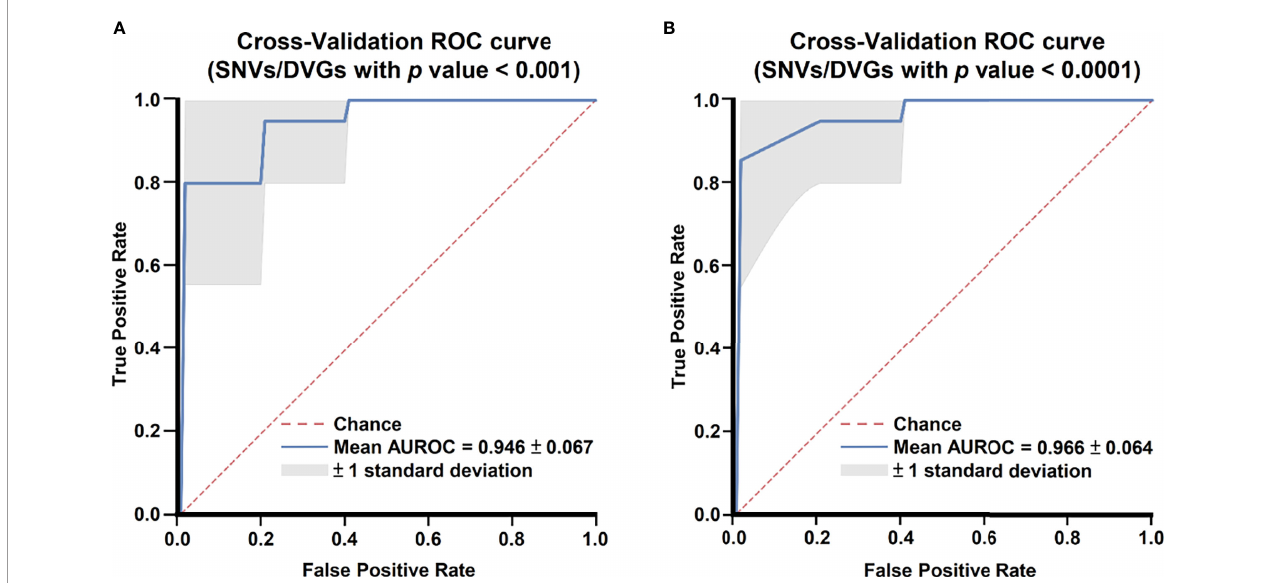
FIGURE 6 | Comparing receiver operating characteristic curves of ML models with 10-fold cross-validation. Mean receiver operating characteristic curves of ML models with selected SNVs/DVGs with (A) p < 0.001 and (B) p < 0.0001 in Mann – Whitney U test are shown.